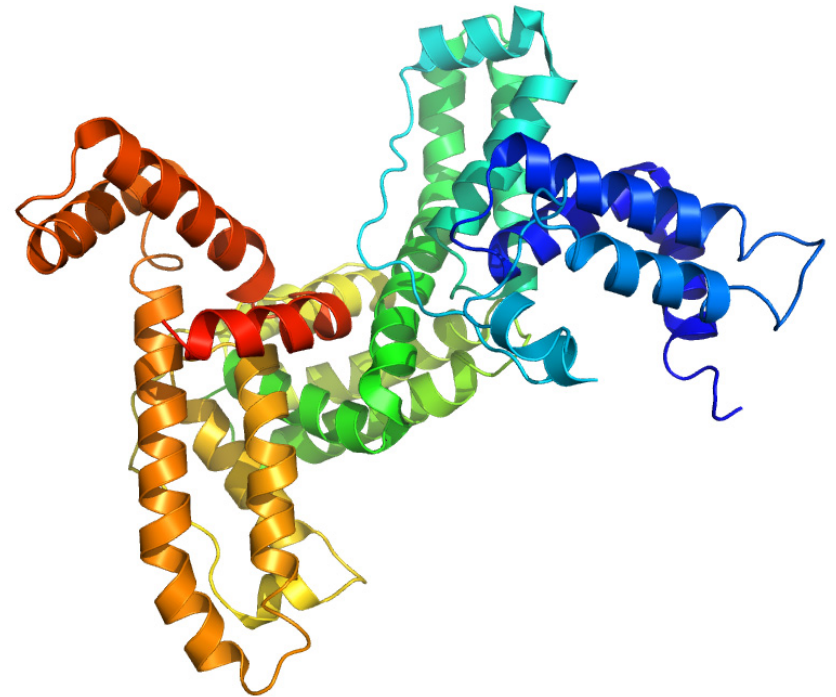
Figure 9. Crystal structures of the vitamin D-binding protein. The illustration was produced by PyMol using the atomic coordinates from the Protein Data Bank, PDB1J78